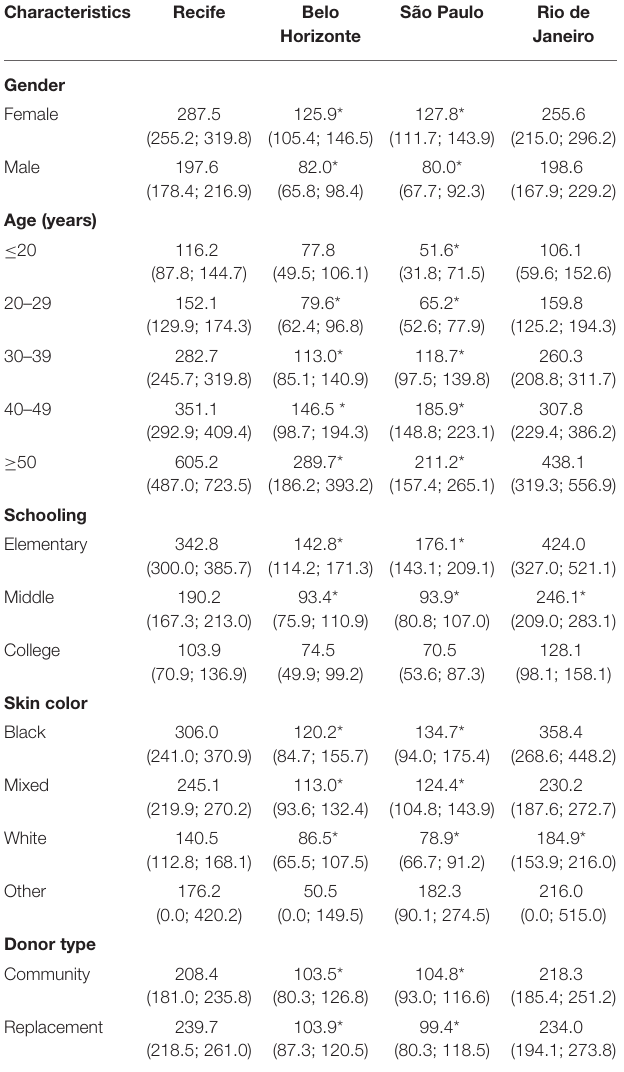
TABLE 3 | HTLV-1/2- prevalence (95% confidence interval) from 2007 to 2016 (10 years) in the four participating blood banks.